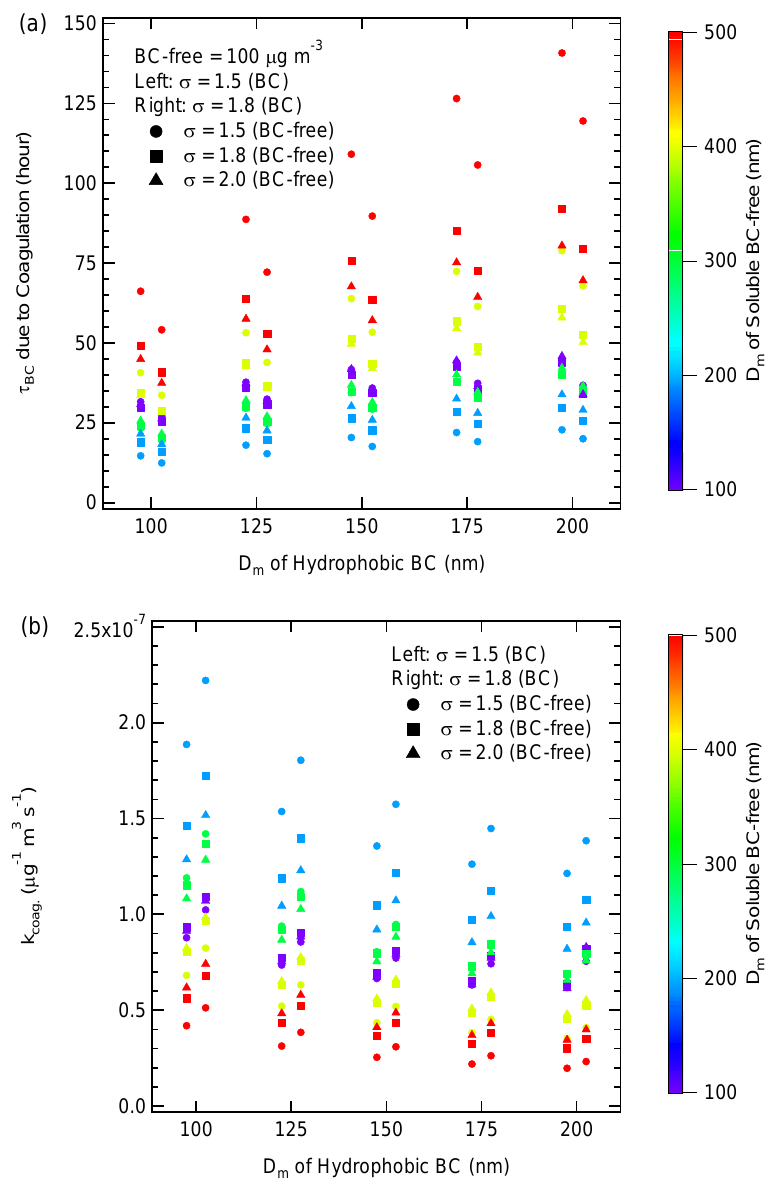
Fig. A1. Variations of (a) τ coag. and (b) corresponding k coag. values for the coagulation between all combinations of the D m and σ values BC Fig. A1. of the size distributions of hydrophobic BC and soluble BC-free particles shown in Table A1. The τ coag. concentration of soluble BC-free particles of 100µgm − 3 . The left-hand and right-hand sides of each D m of hydrophobic BC particles denote the values for σ of hydrophobic BC particles of 1.5 and 1.8, respectively. Circles, squares, and triangles denote the values for σ of soluble BC-free particles of 1.5, 1.8, and 2.0, respectively. Colors indicate the values for D m of soluble BC-free particles.